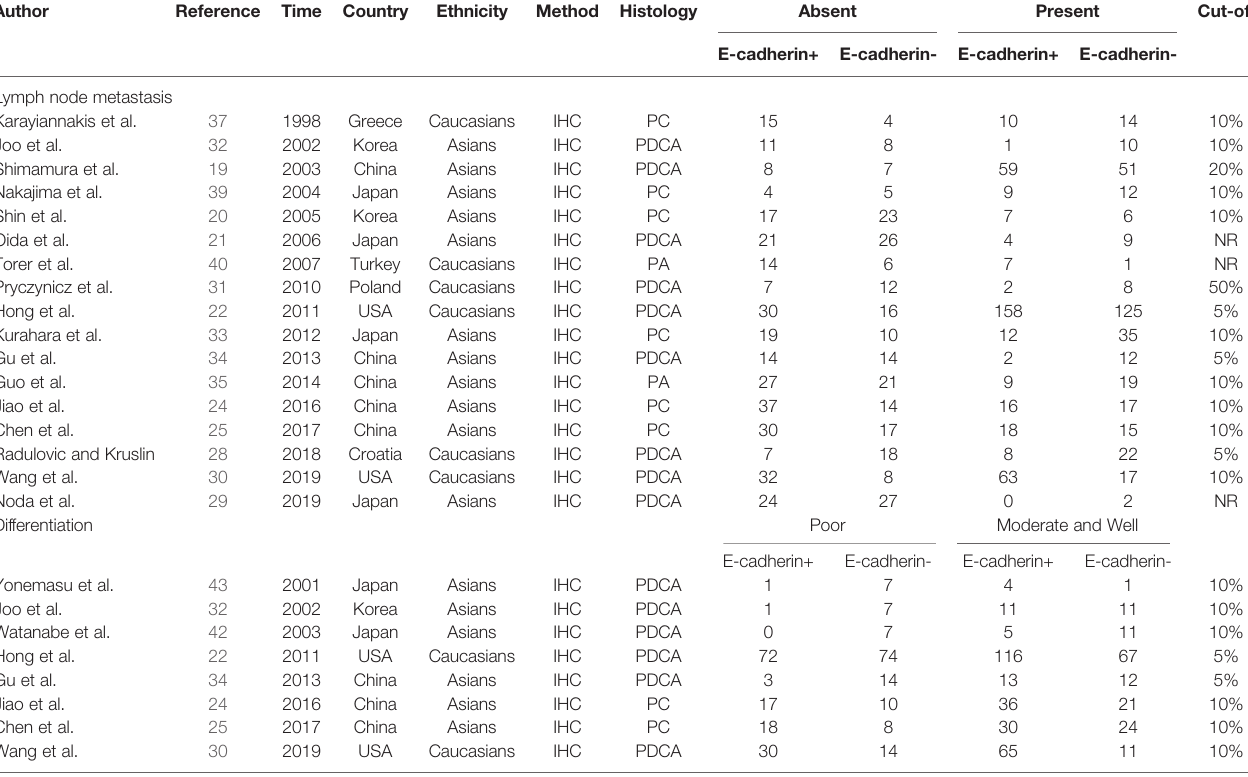
TABLE 2 | Characteristics of eligible studies in the meta-analysis for the clinical features of pancreatic cancer. Author Reference Time